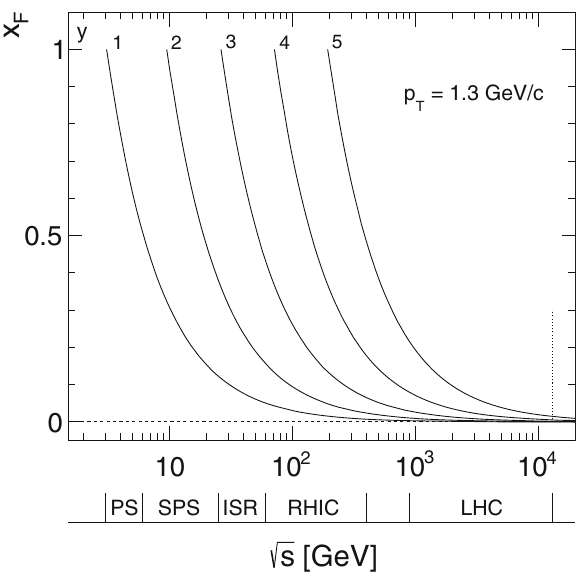
√ s for different y values,